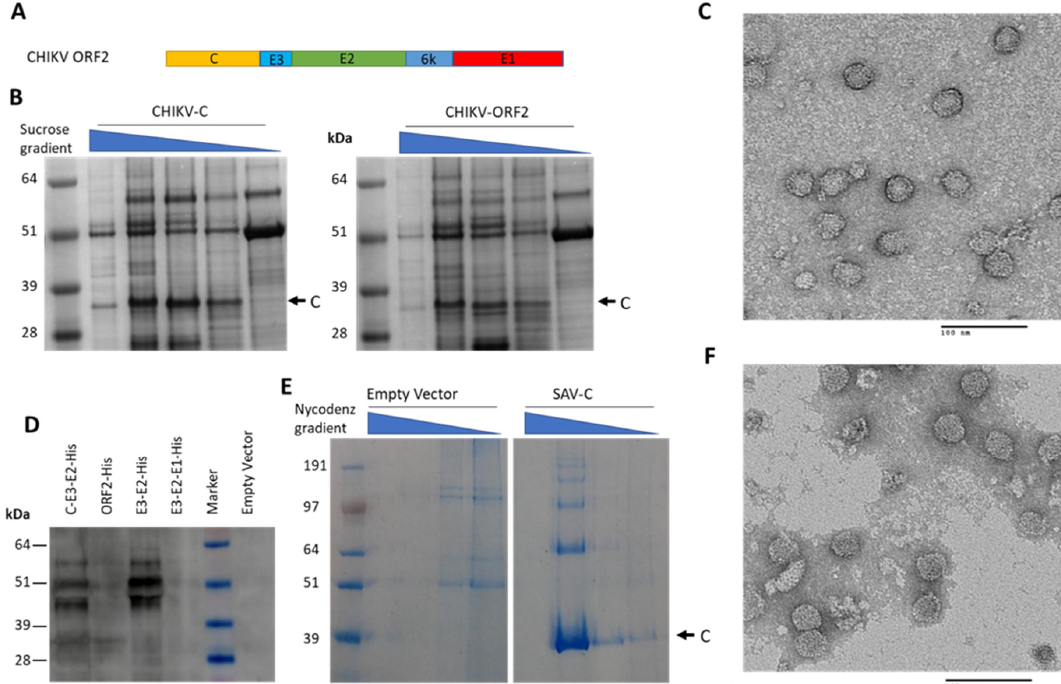
Figure 5. Alphavirus structural proteins are expressed in plants and self-assemble into capsid-like structures. Proteins of CHIKV ( A – D ) and SAV ( E , F ) were transiently expressed in N. benthamiana from pEAQ-HT constructs for capsid protein, the entire open reading frame 2 (ORF2), or portions of ORF2 with C-terminal histidine tag. ( A ) Schematic representation of CHIKV-ORF2. ( B ) InstantBlue-stained SDS-PAGE gels of gradient fractions from CHIKV-C and CHIKV-ORF2-expressing tissue. CHIKV capsid protein band indicated. ( C ) Transmission electron micrograph of CHIKV-C sucrose gradient fraction. ( D ) Western blot of crude leaf extract probed with anti-his antibody, showing production of his-tagged CHIKV-E2. ( E ) InstantBlue-stained SDS-PAGE gel of Nycodenz gradient fractions for purification of SAV capsid protein (N-terminally his-tagged) or empty vector control. SAV capsid protein band indicated. ( F ) Transmission electron micrograph of N-terminally His-tagged SAV-C Nycodenz gradient fraction. Samples stained with 2% ( w / v ) uranyl acetate before TEM imaging, scale bars 100